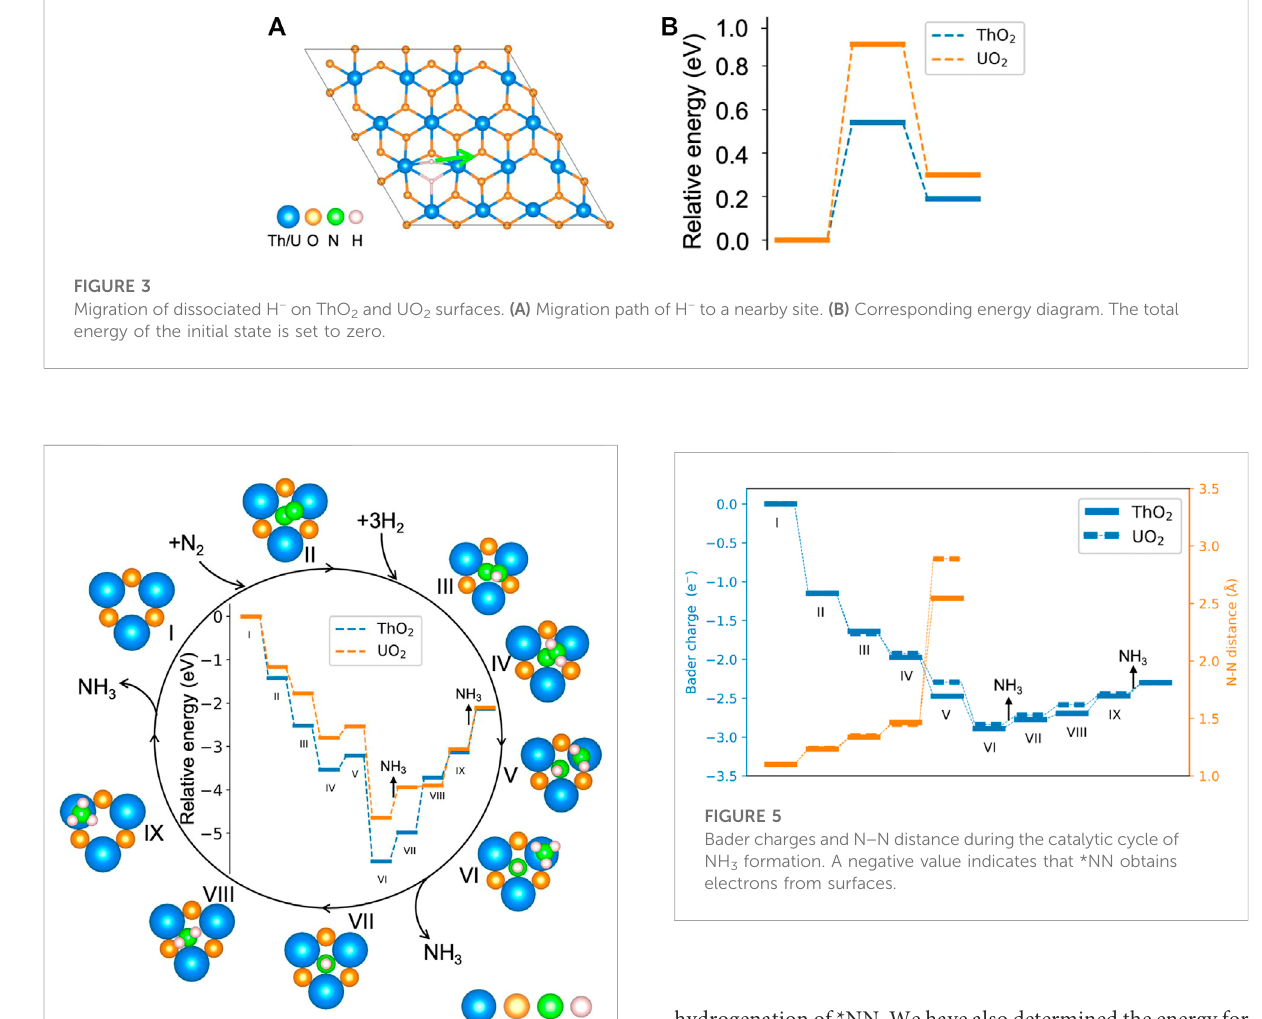
− 3E H 2 , where E Total is 2 and E H are the 2 2